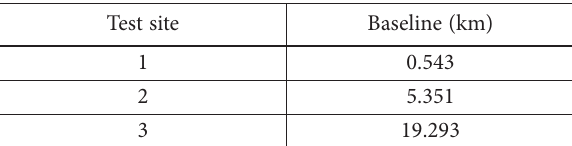
Table 1. Distance master-rover of test sites